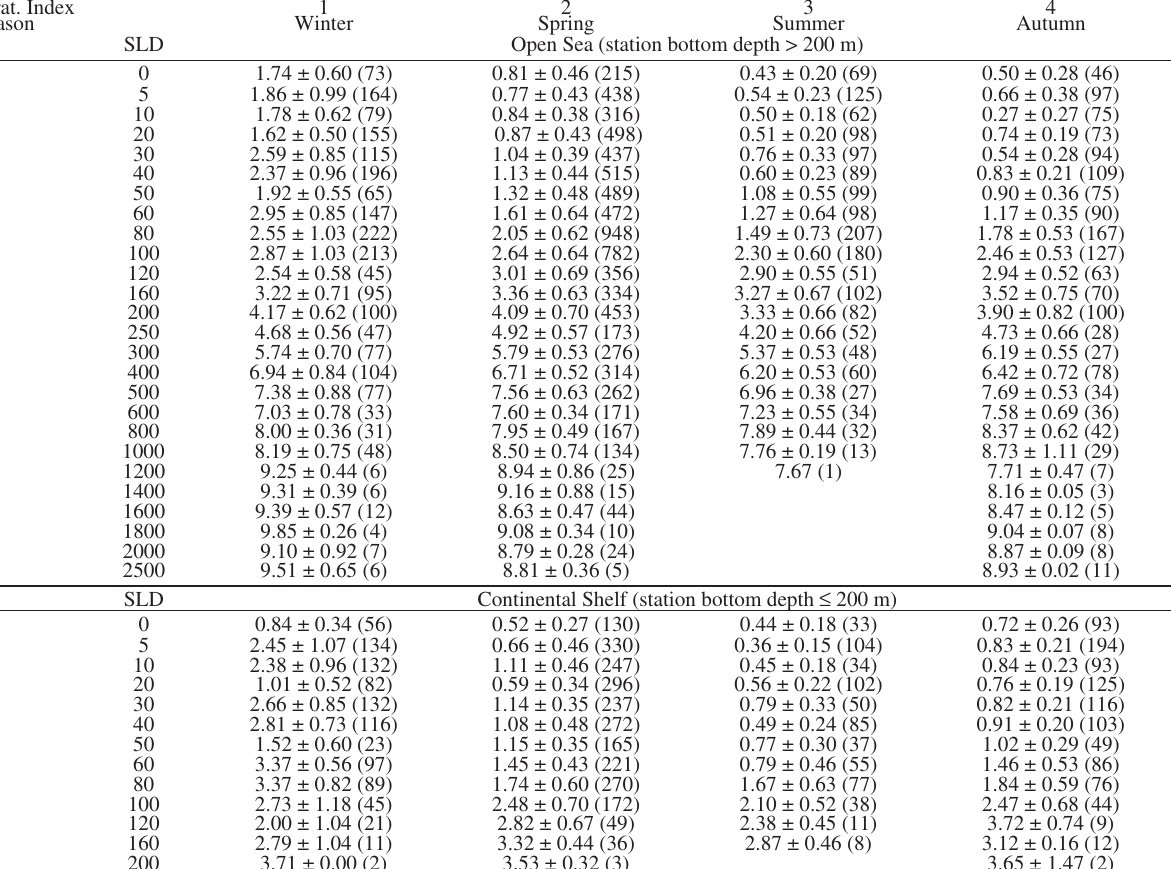
Table S7. – Chlorophyll a concentration (μg L -1 ) with depth and stratification of the water column in the Catalan Sea (NW Mediterranean Sea). Shown are median ± median absolute deviation (number of data between parentheses). SL, Standard Level; SLD, Standard Level Depth (m). Strat.